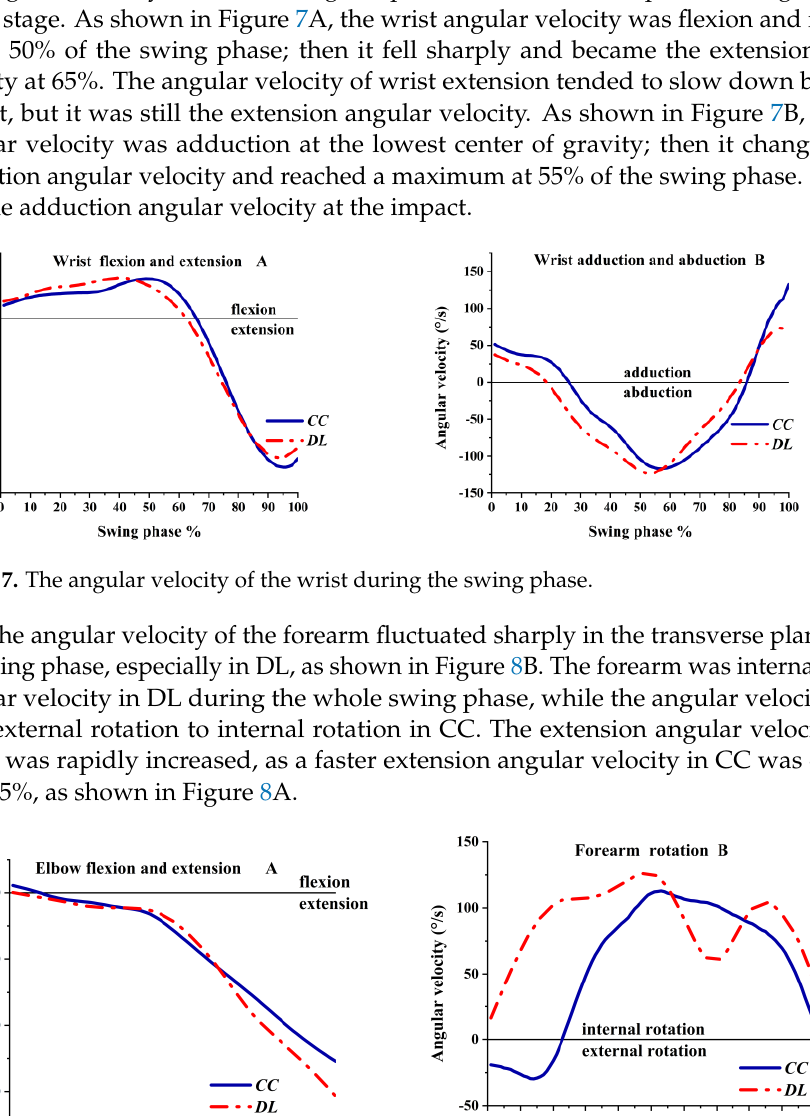
Figure 8. The angular velocity of the elbow during the swing